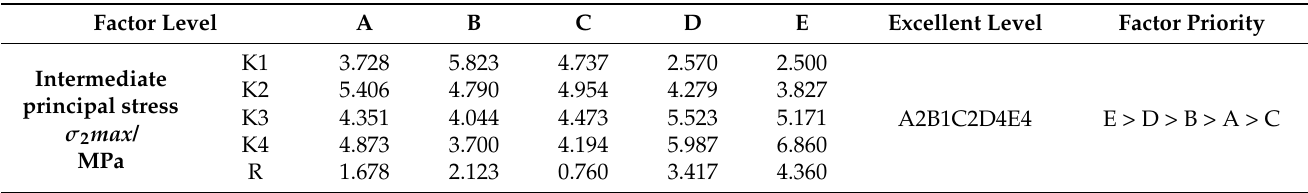
Table 6. Analysis of the degree of influence of various factors on intermediate principal stress σ 2